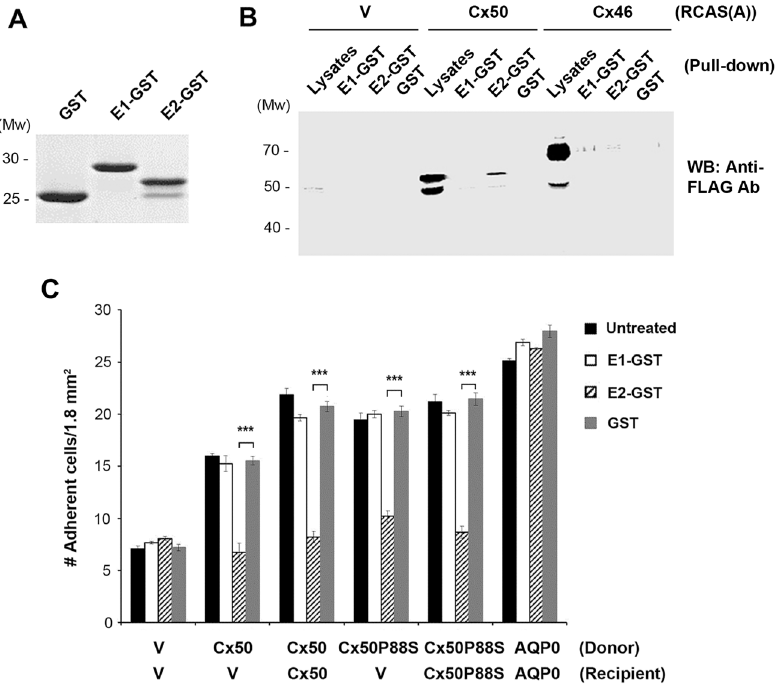
Figure 3. Second extracellular loop domain (E2) Cx50 mediates the adhesion function of Cx50 and this function is independent of forming functional connexin channels. ( A ) GST-fusion protein containing E1 and E2 domains were generated and detected by Commassie blue staining. ( B ) High titter recombinant retroviruses containing RCAS(A) vehicle (V), Cx50 and Cx46 were used to infect CEF cells and cell lysates were prepared. Protein pull down assay was performed using cell lysates and E1-GST, E2-GST or GST attached to glutathione beads. Cell lysates (Lysates) and elutes (E1-GST, E2-GST or GST) from the beads were immunoblotted with anti-FLAG antibody. ( C ) High titter recombinant retroviruses containing RCAS(A) vehicle (V), Cx50, Cx50P88S mutant or AQP0 were used to infect CEF cells in the absence or presence of GST-fusion protein containing E1 or E2 domain. Cell adhesion assay was conducted and adherent cells were counted and quantified. The data are presented as the mean ± SEM. n = 3. *** P <